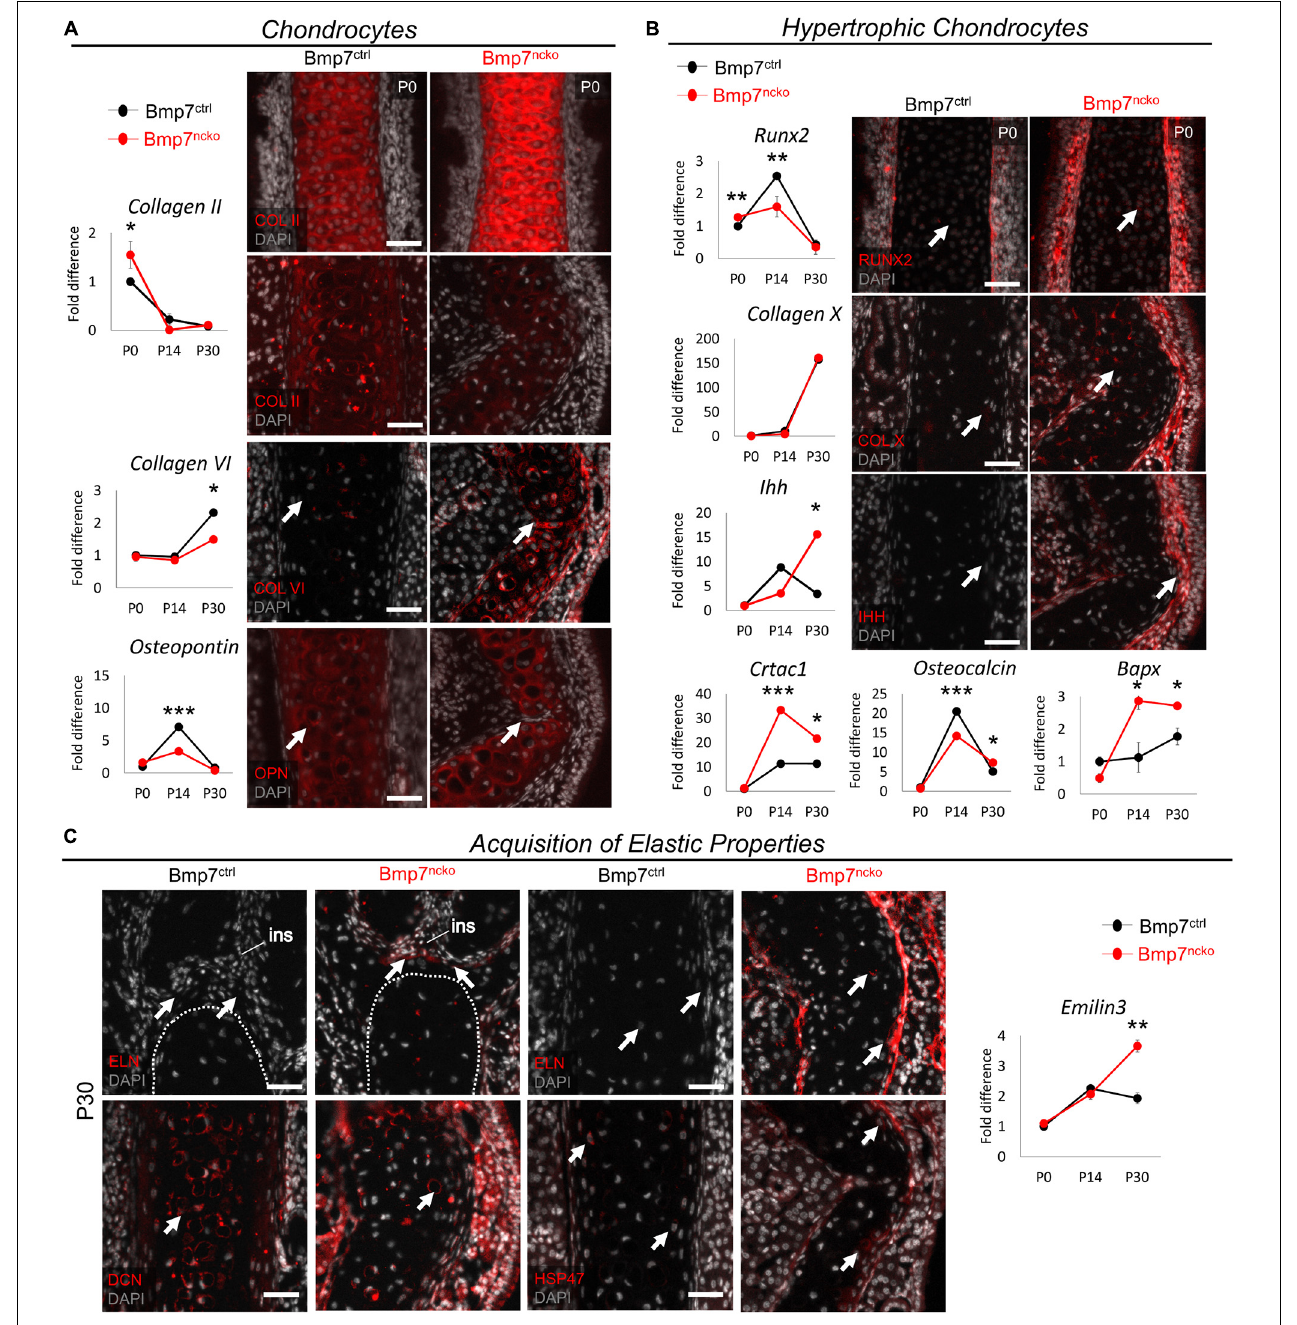
FIGURE 4 | Bmp7 ncko mice undergo chondrocyte hypertrophy and acquire elastic cartilage markers. (A) qRT-PCR of dissected nasal septum demonstrating differential gene expression of Collagen II (COL II), Collagen VI (COL VI), and Osteopontin (OPN) at P0, P14, and P30 timepoints. Immunofluorescence staining of COL II revealed an increase at P0 (top panel) and a decrease at P30 (bottom panel). Expression of COL VI was increased in the Bmp7 ncko mice while reduced expression of OPN was observed in P30 mutant mice via immunofluorescence. (B) Differential gene expression of genes involved in chondrocyte hypertrophy RUNX2, Collagen X (COL X), Indian hedgehog (IHH), Cartilage acidic protein 1 (CRTAC1), Osteocalcin, and Bapx indicating Bmp7 ncko mice undergo chondrocyte hypertrophy. Immunofluorescence staining of P0 nasal septum demonstrates an increase in RUNX2 expression in addition to an increase in expression of COL X and IHH in P30 Bmp7 ncko mice. (C) Expression of Elastin (ELN) was observed in the abutment of the nasal septum and internasal suture (ins) as well as in the middle of the nasal septum in P30 Bmp7 ncko mice. EMILIN3 expression was also significantly increased at P30 in the mutant mice. Expression of Decorin (DCN) and SERPINH1 (HSP47) were also identified to be increased in the mutant nasal septum. Independent two-tailed t -test was performed with significance denoted as *: p < 0.05, **: p < 0.01, ***: p < 0.001. ( n = 3/genotype/age). Antibody expression demonstrated in red and DAPI stained nuclei in gray for all immunofluorescence images. Arrows denoting positive antibody signal. Scale bar = 50 µ